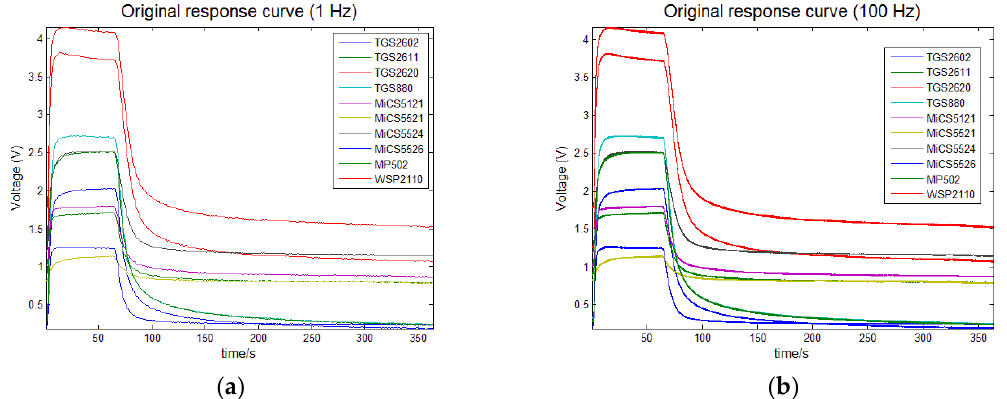
Figure 7. Response curves of the sensor array, ( a ) represents the original response curve (1 Hz); ( b ) represents the original response curve (100 Hz).